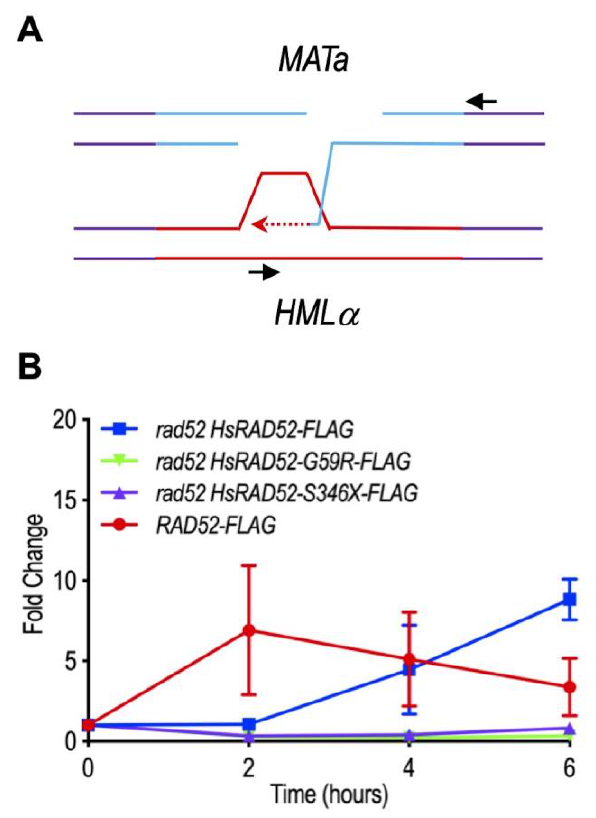
FIGURE 7: The adh1::HsRAD52-G59R-FLAG and adh1::HsRAD52- S346X-FLAG alleles confer defects in repair synthesis during MTI. (A) Cartoon depicting extension by repair DNA synthesis of putative heteroduplex formed upon association between sequences at the MAT and HML loci during MTI. Following DSB formation at the MAT locus (blue lines) exonucleolytic processing creates ssDNA onto which ScRad52-FLAG and HsRAD52-FLAG are proposed to bind. A search for homology putatively results in formation of a heterodu- plex linking homologous sequences at the broken MAT locus with sequences at the intact HML locus (solid red lines). Extension of the heteroduplex by DNA repair synthesis (dotted red line) copies “ ⍺ ” information from HML that replaces “a” information lost from MAT , ultimately resulting in a change from MATa to MAT ⍺ . Repair syn- thesis ultimately covalently joins “ ⍺ ” information from HML with sequences downstream from the MAT locus, which can be detected by PCR using the depicted primers (black arrows). (B) Repair syn- thesis was defective in rad52 adh1::HsRAD52-G59R-FLAG and rad52 adh1::HsRAD52-S346X-FLAG mutant cells. Genomic DNA was col- lected before immunoprecipitation from the same wild-type